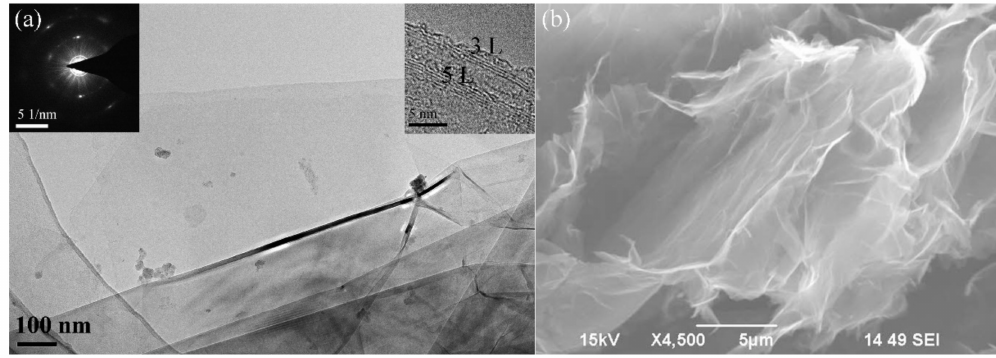
Figure 5. ( a ) Representative TEM image and ( b ) SEM image of recovered sample. The scale bars of SAED pattern and HRTEM image in inset of Figure 5a are 5 1/nm and 5 nm,